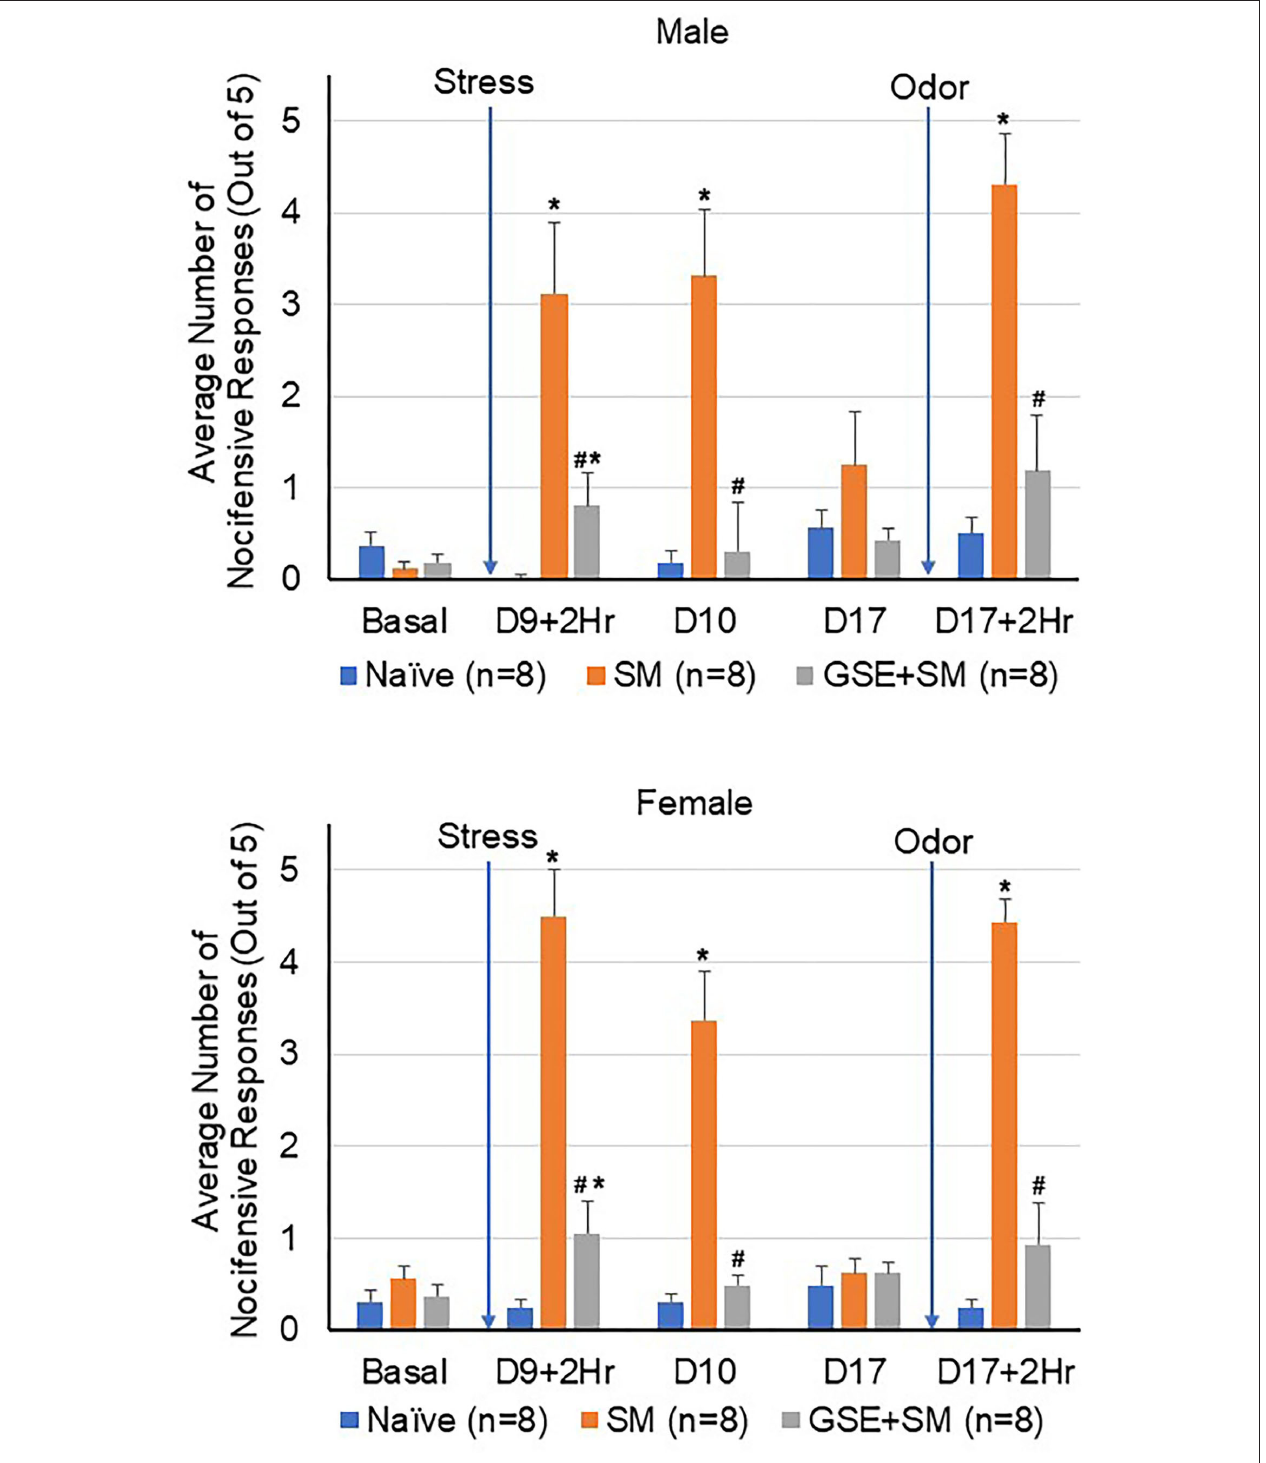
FIGURE 2 | GSE supplementation inhibits trigeminal nociception in the orofacial region mediated by pungent odor in latent-sensitized animals. The average number of nocifensive head withdrawal responses ± SEM to mechanical stimuli are reported for male (top panel) and female animals (bottom panel) . Some animals were left untreated (Naïve) while other animals were subjected to restraint stress for 3 consecutive days prior to exposure to pungent odor on day 9 (stress model, SM). Some animals received daily GSE in lieu of water for 1 week prior to restraint stress and supplementation was continued for remainder of study (GSE + SM). * P < 0.05 when compared to Naïve mechanical sensitivity levels at that time point. # P < 0.05 compared to SM levels.